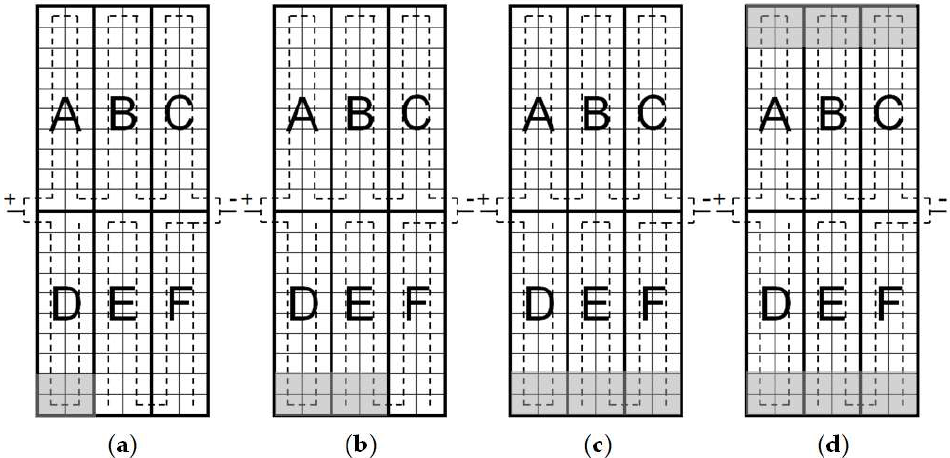
Figure 3. Shading places of the PV module from half cells for the four considered cases verified: ( a ) shading of four halves of PV cells; ( b ) shading of eight halves of PV cells; ( c ) shading of twelve halves of PV cells; and ( d ) shading of twenty-four halves of PV cells.